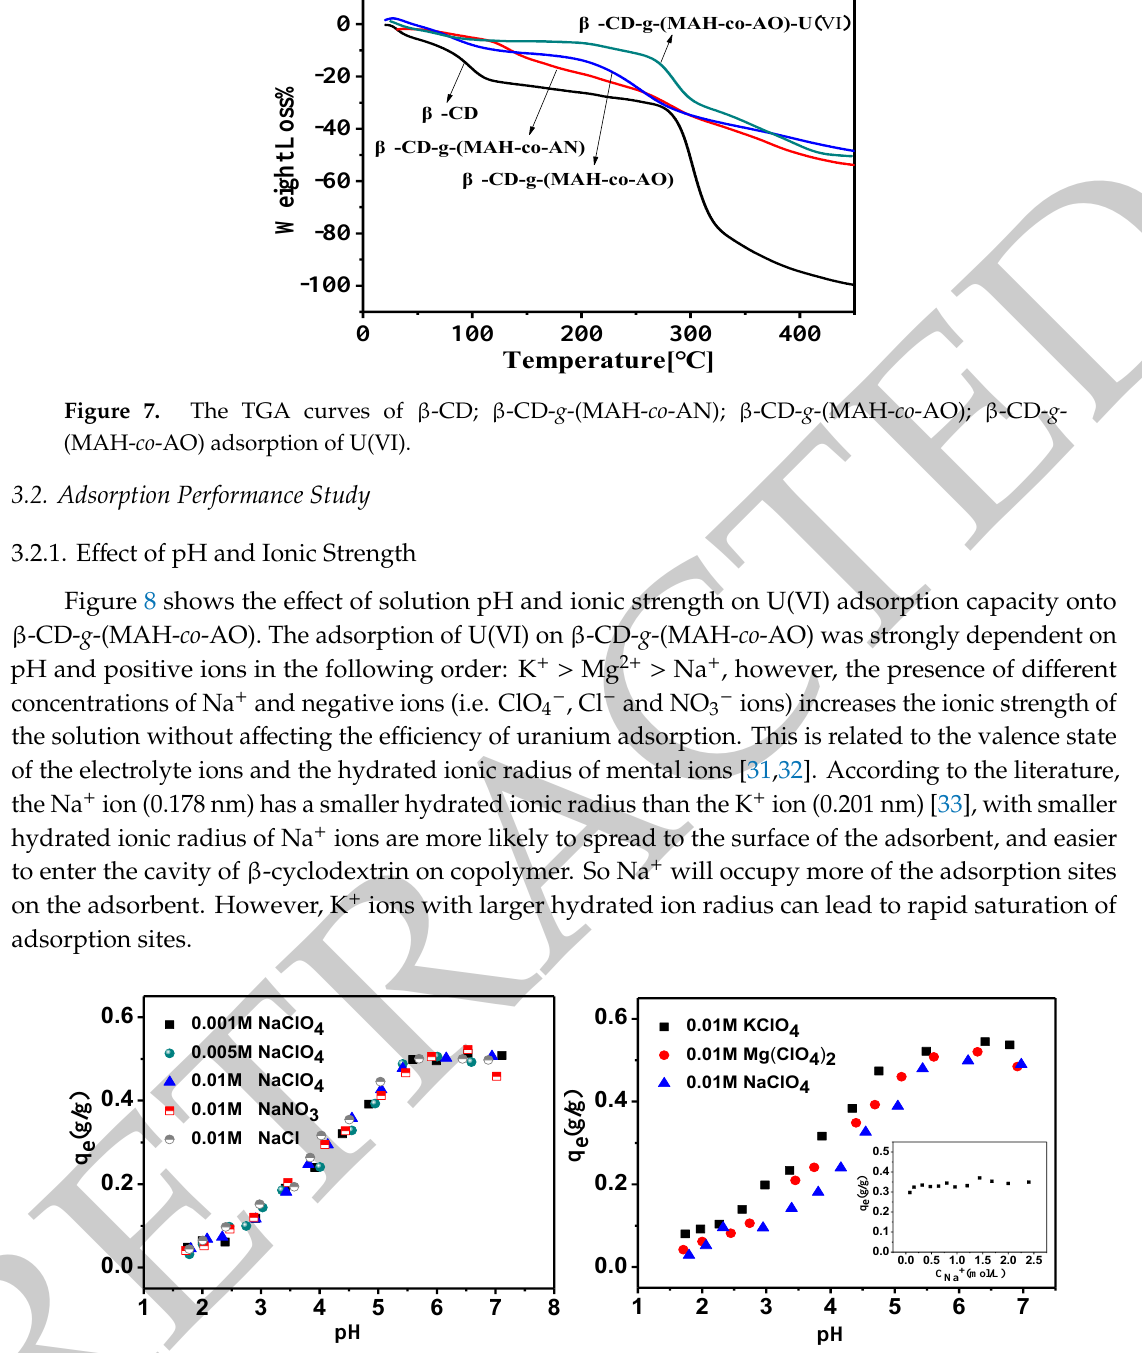
Figure 8. The adsorption of U(VI ) onto β -CD- g -(MAH- co -AO) copolymer as a function of pH at different ionic strength. (Conditions: [U(VI)] 0 = 4.1240 × 10 −4 M, T = 298.15 ± 1.00 K, t = 4 h, m / V = 0.20 g/L).